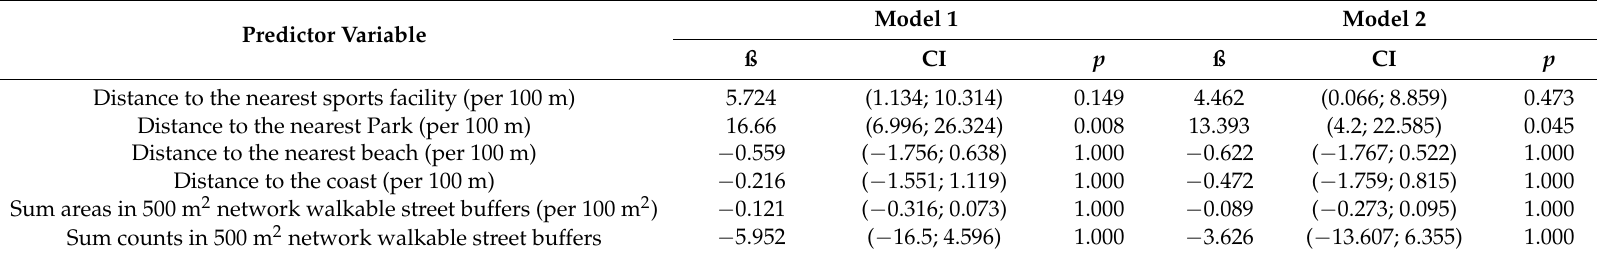
Table 3. Summary of the results from the generalized linear regression (GLM) for the association between access to Public Open Spaces (POS) and total leisure time physical activity (LTPA). The results for the following model comparisons are provided: unadjusted GLM (Model 1) GLM adjusted by individual-level covariates (sex, age, body mass index, educational level and smoking habits). Due the use of multiple comparisons we applied the Bonferroni post-hoc correction on both model.